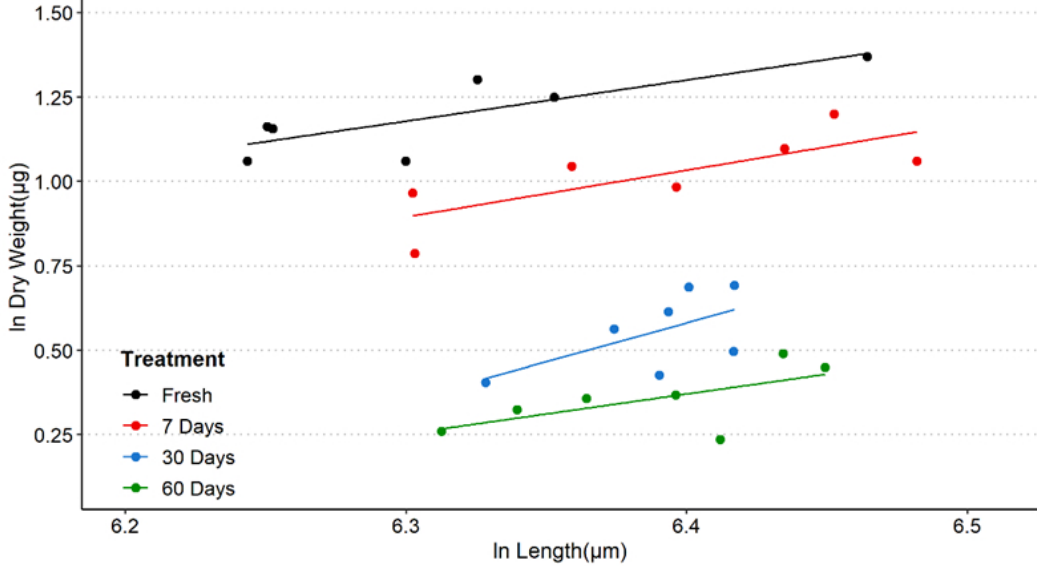
Figure 3. Scatterplot of dry weight (response variable) against body length (the covariate variable), on the experimental